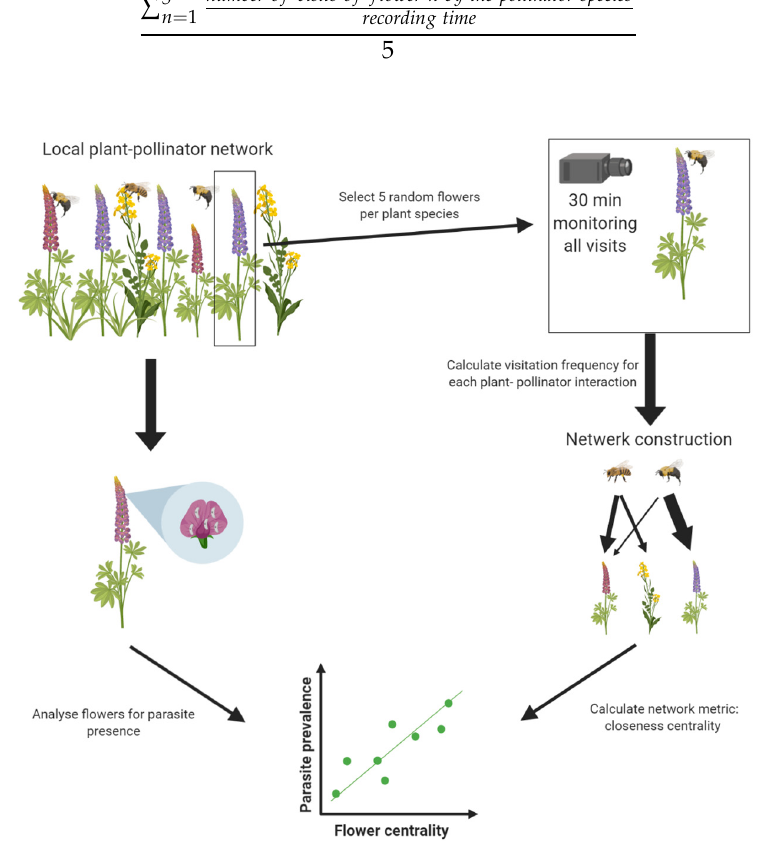
Figure 1. Schematic overview of the network construction and relationship between flower centrality and parasite prevalence. In three local plant–pollinator networks, 5 random flowers of each plant species present at the site were recorded using a camera. This data was used to construct the weighted plant–pollinator networks, where we calculated the visitation frequency for each plant–pollinator interaction (see Section 2.2 on network construction for full details). From the resulting networks, the centrality of each plant species was calculated. We analyzed the parasite prevalence on the flowers of each plant species and looked at the relationship between parasite prevalence on the flowers and flower centrality using a generalized linear mixed model.